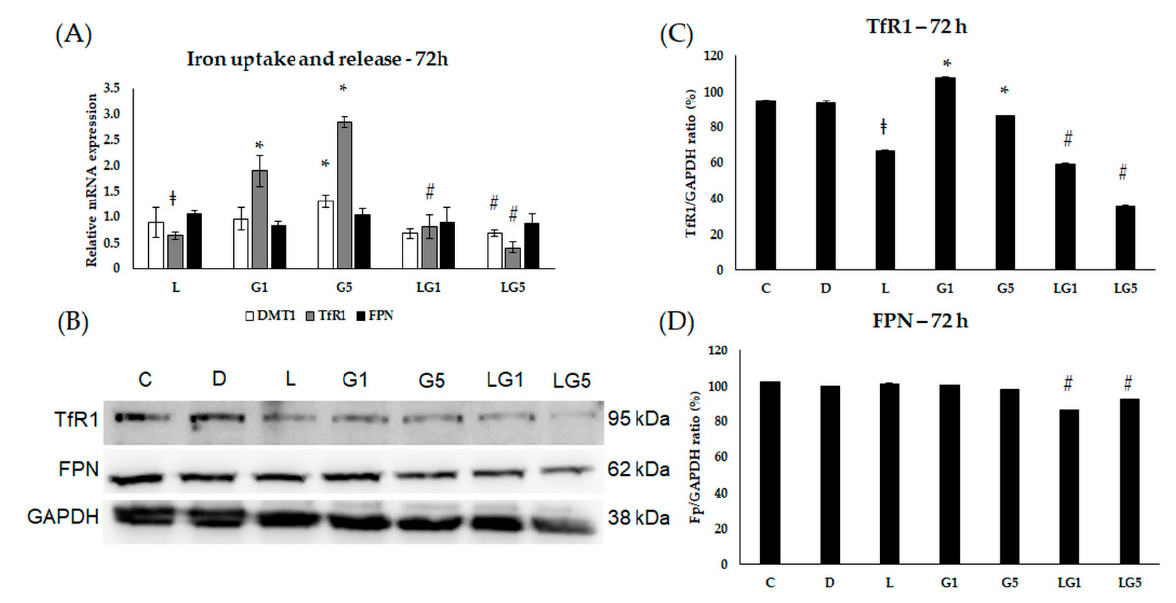
Figure 8. Determination of mRNA expression ( A ) and protein ( B – D ) levels of TfR1, DMT1, and FPN after lutein and Glu treatments of the SH-SY5Y cells at 72 h. SH-SY5Y cells were treated with 10 ng/ µ L of lutein, 1 mM, 5 mM Glu, or lutein with Glu together to detect the changes in the expression of TfR1, DMT1, and FPN. The gene expression measurements were performed by SYBR Green RT-PCR protocol with β -actin as a housekeeping gene. The relative expression of controls was regarded as 1. The protein expression measurements were performed by semi-dry Western blotting using GAPDH as a loading control. The protein’s OD was expressed as a percentage of the target protein/GAPDH ratio. The bars represent the mean values ( ± standard deviation error bars, SD) of three independent experiments ( n = 3) performed in triplicate and are presented relative to their control cells. The * marks the statistical significance of Glu treatments compared to control, ‡ shows the statistical significance of lutein treatments compared to control, # signs the statistical significance of combined (lutein with Glu) treatments compared to the Glu treatments at 72 h ( p < 0.05).